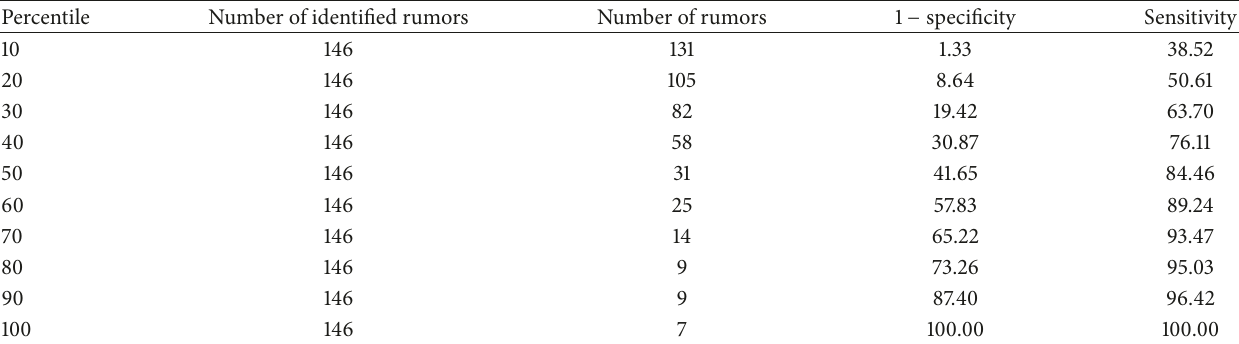
Table 2: ROC statistics of the maximum entropy model.